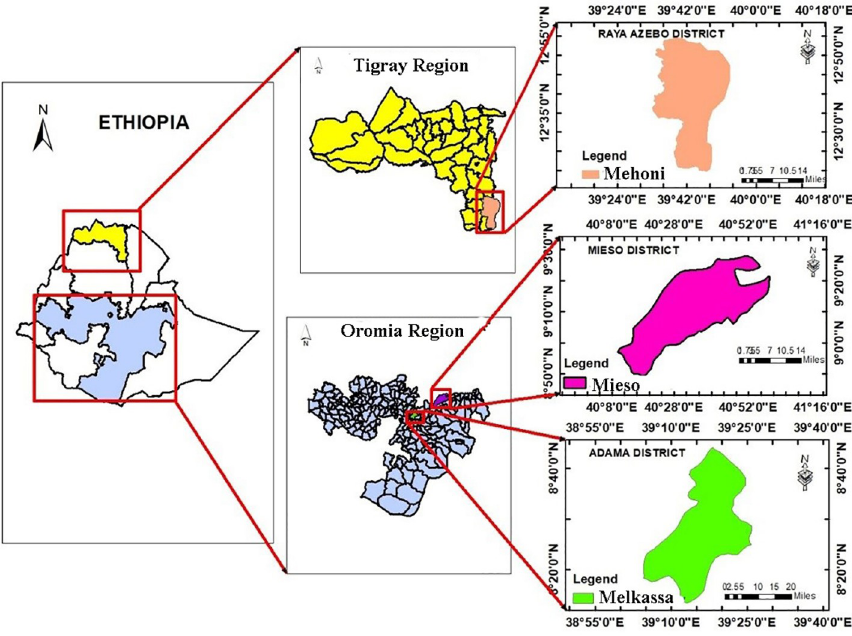
Fig 1. Geographical map, constructed using geographic information system (ArcGIS), [24] showing the three testing environments: Mehoni, Mieso and Melkassa in Ethiopia. Mehoni is located in Raya Azebo district of Tigray Regional State whereas Mieso and Melkassa are located in Mieso and Adama districts of Oromia regional State, respectively.